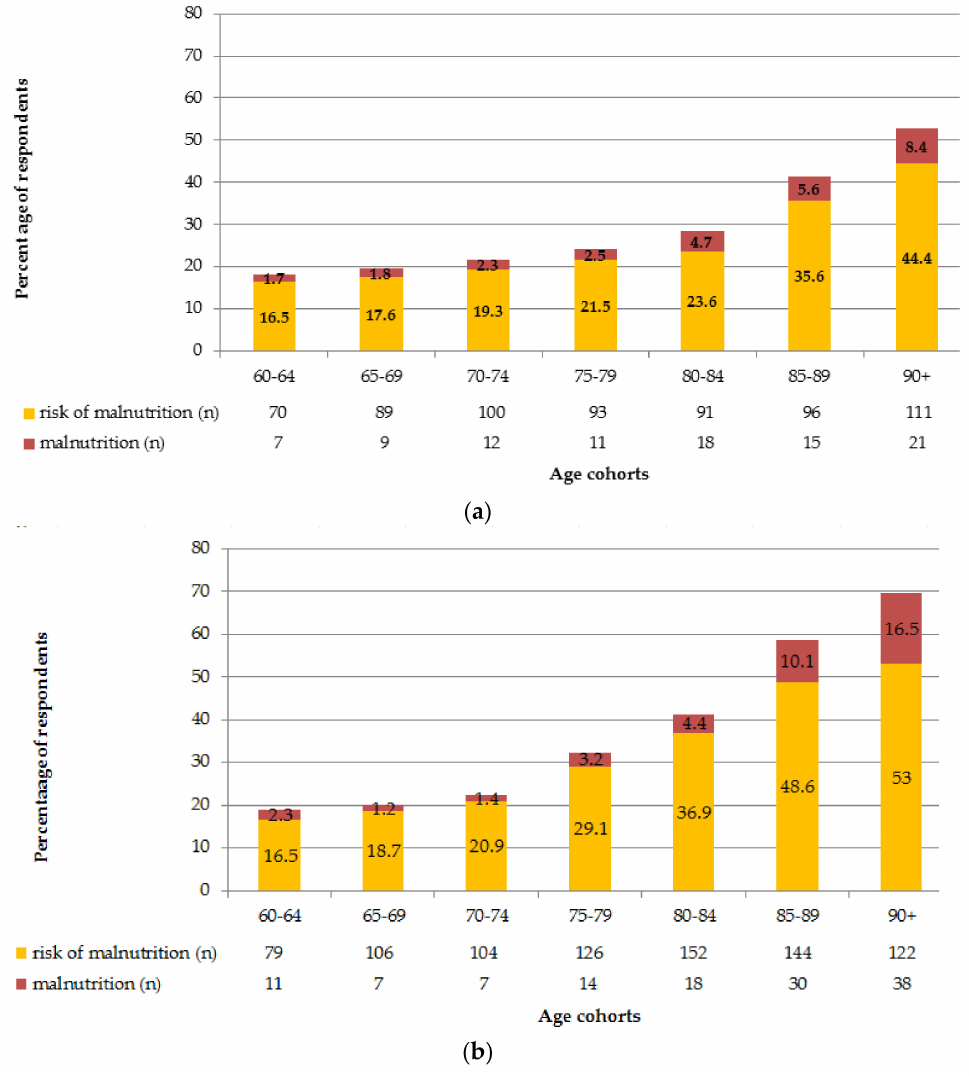
Figure 1. ( a ). The frequency of malnutrition and its risk in the Polish older men stratified by age. ( b ). The frequency of malnutrition and its risk in the Polish older women stratified by age. Table 1. Frequency of poor nutritional status (malnutrition or risk of malnutrition based on MNA-SF screening) in subgroups by socioeconomic